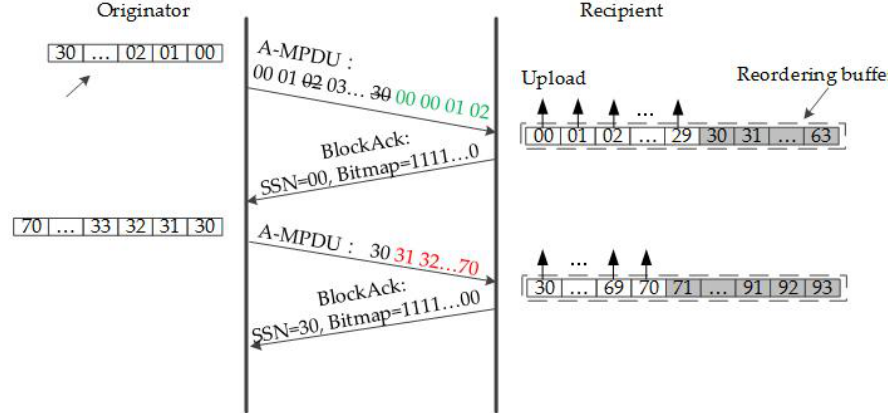
Figure 5. An example of the A-MPDU transmission using the backup padding ARQ (BP-ARQ) scheme where W =